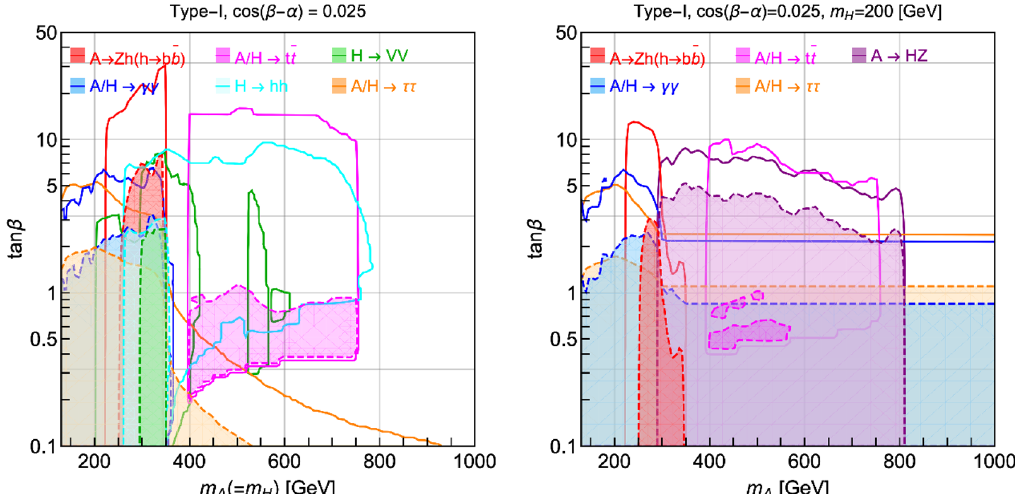
Figure 2 . Excluded regions at 95% C.L. in the m A dashed line boundaries) and HL-LHC (solid lines) via di(cid:11)erent channels: (cid:28)(cid:28) (orange), t (cid:22) t (magenta), V V (green), (cid:13)(cid:13) (blue), H